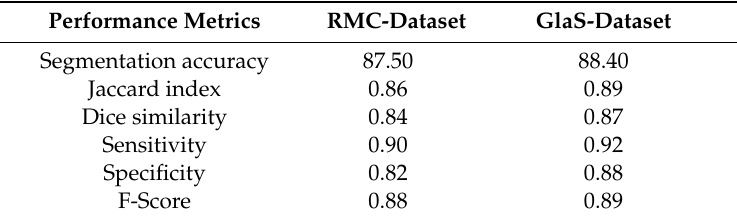
Table 1. Performance of the proposed gland segmentation method.